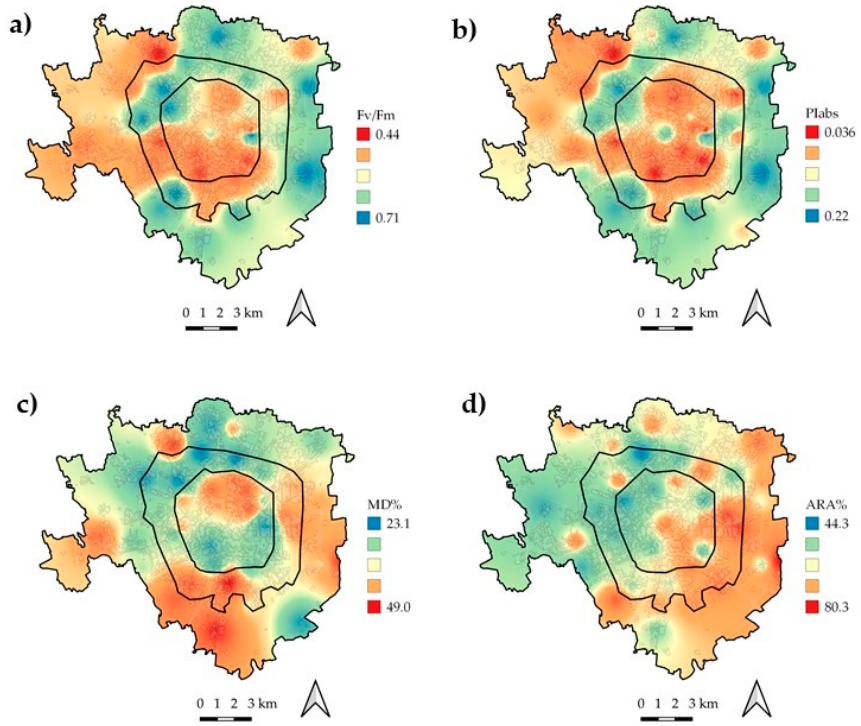
Figure 2. Distribution maps of the physiological parameters over the study area. ( a ) Fv/F M , ( b ) PI ABS , ( c ) MD%, and ( d ) ARA%.